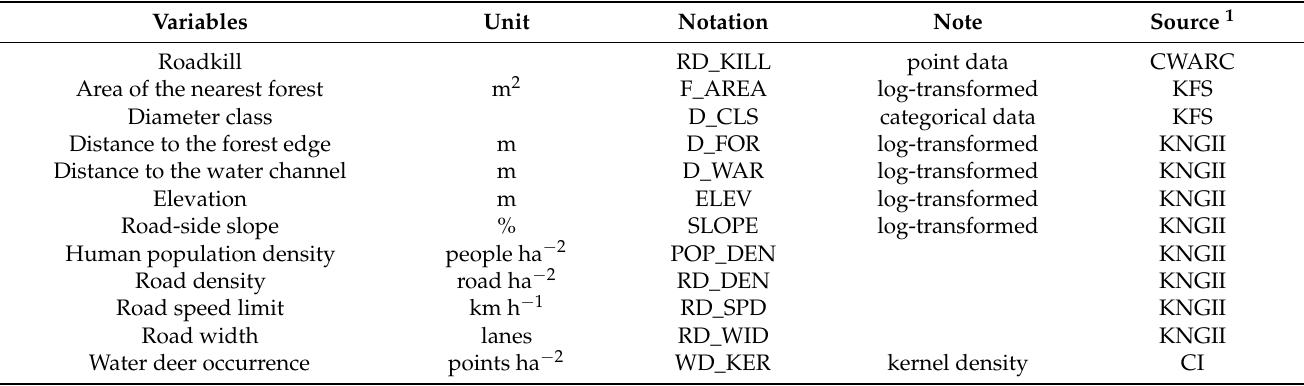
Table 1. Description of variables for model